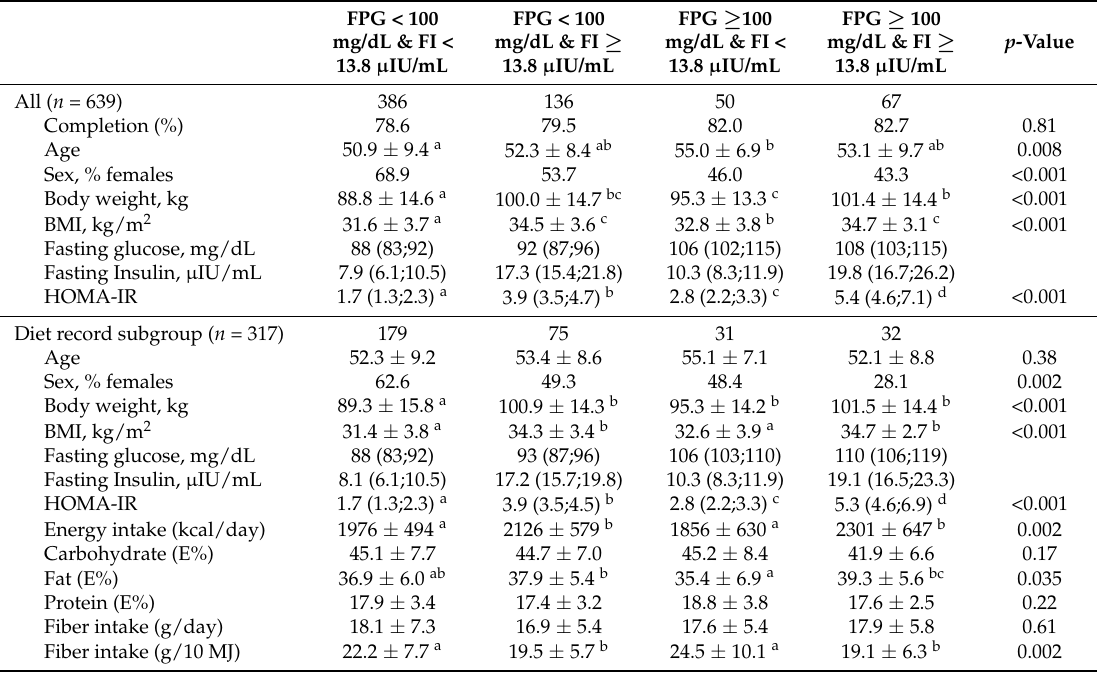
Table 1. Baseline characteristics of the completing study populations stratified by fasting glucose and